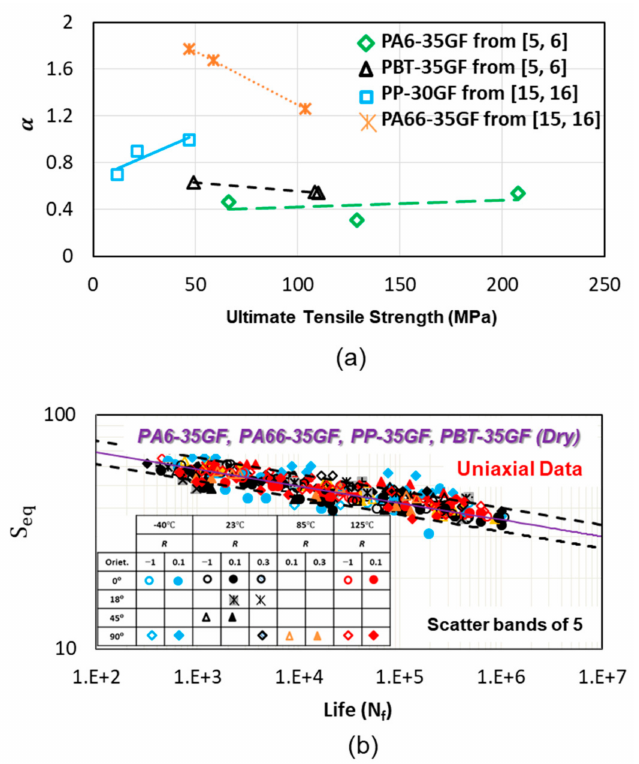
Figure 7. ( a ) Constant α used in general model as a function of ultimate tensile strength. ( b ) Uniaxial fatigue data correlations of PA66-30GF, PP-30GF, PBT-35GF, PA6-35GF using the proposed damage parameter and the general model from